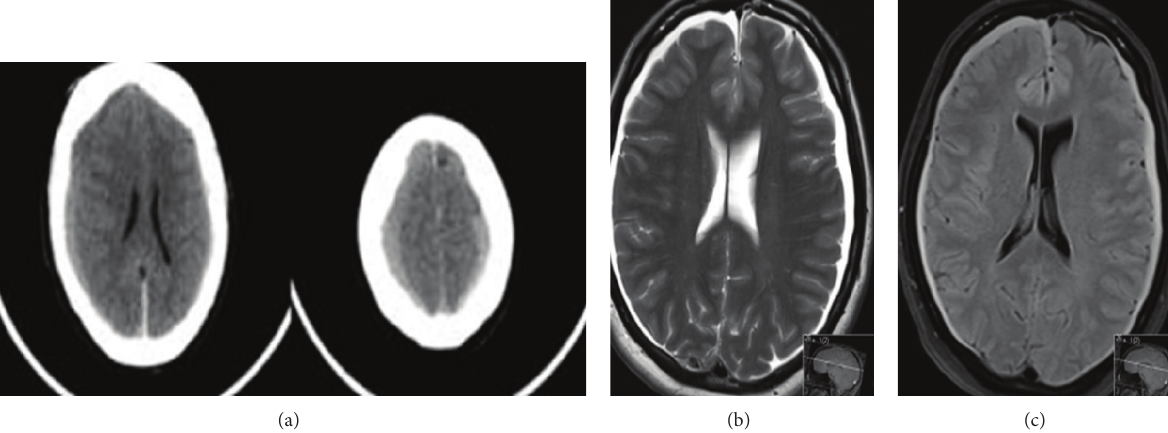
Figure 1: (a) Noncontrast head CT: bilateral hematomas are present. These are predominantly isodense to slightly hypodense compared to the adjacent gray matter (29–35 Hounsfield units), which could be explained by anemia (hemoglobin was 9g/dL). (b) and (c) Bilateral subdural hematomas, confirmed as shown in both MRI T2 and FLAIR sequences.